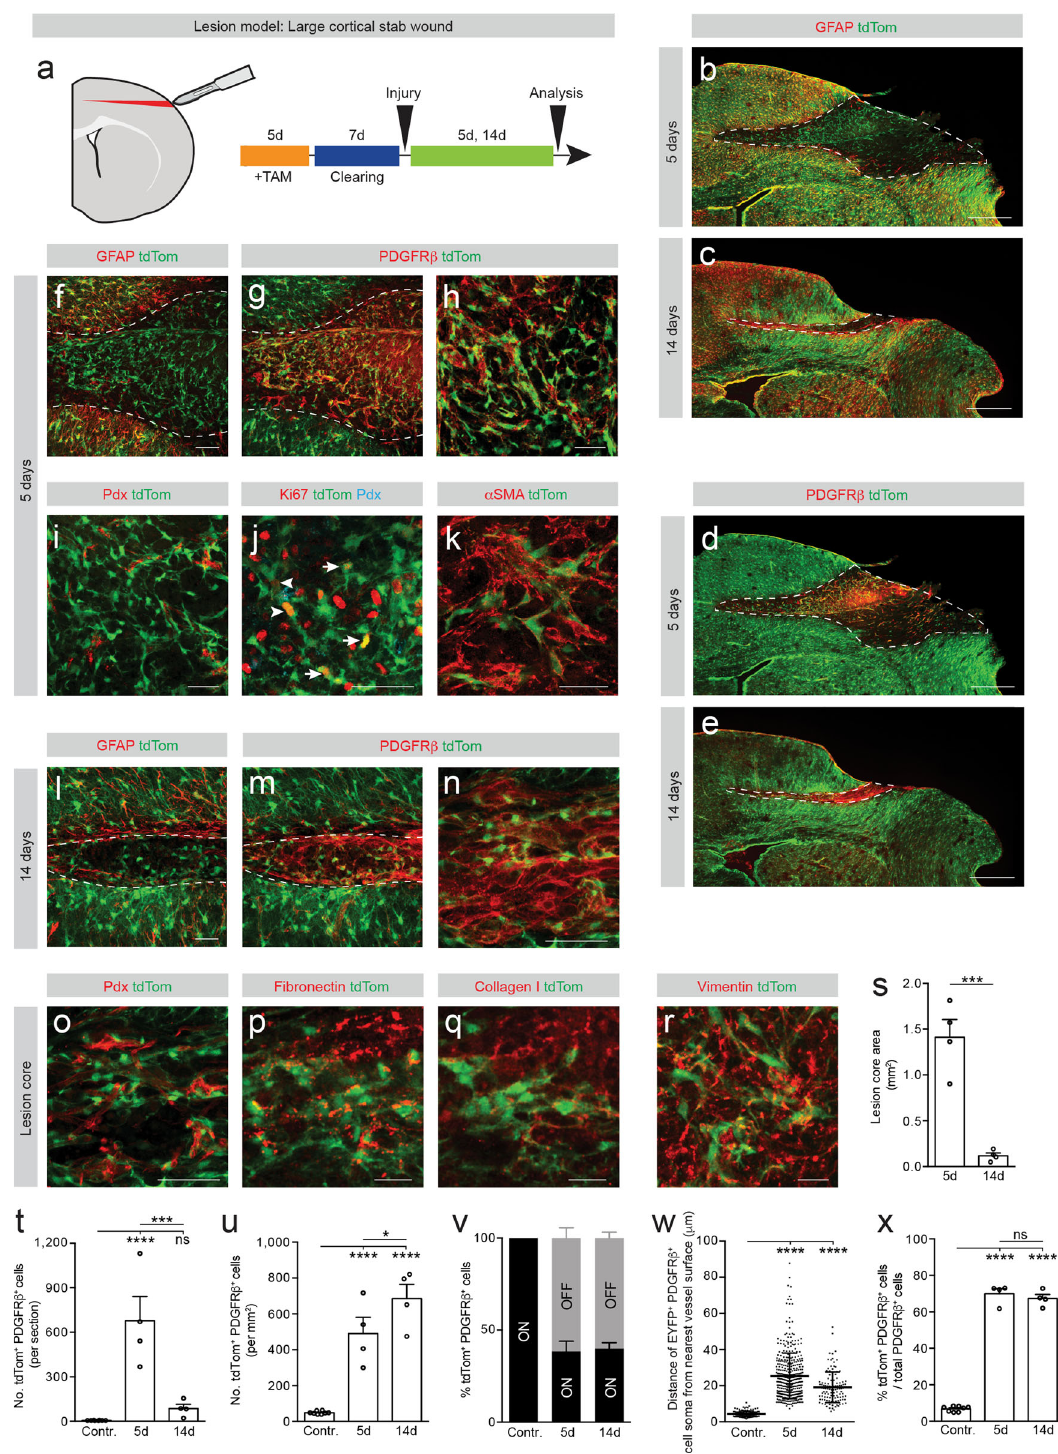
morphology and looser attachment of type A pericytes and progeny to the blood vessel wall in response to stroke, when compared to the contralateral control side (Fig. 5x). Recombined cells proliferated, were encased by fi bronectin and collagen I ECM, but did not express α SMA (Fig. 5r – u), indicating these cells did not transition into (myo) fi broblasts. The number of recombined PDGFR β + stromal cells that had drastically increased in the ischemic lesion core at 5 days